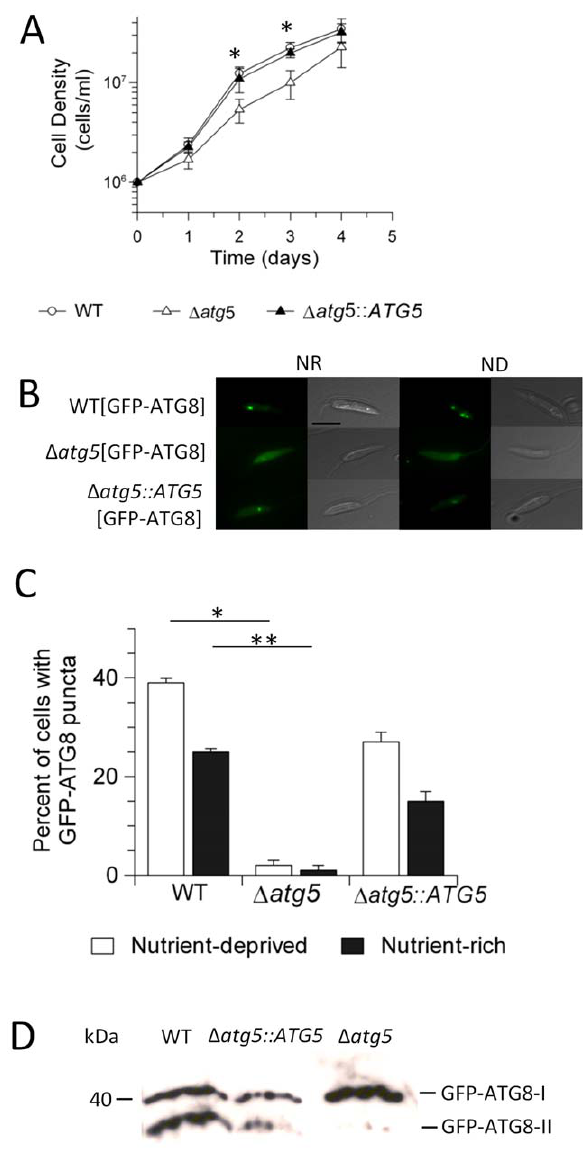
Figure 4. Phenotypic characterisation of D atg5 . (A) Growth curve of Leishmania promastigotes in HOMEM medium at 26 u C. *, D atg5 differed significantly from WT (p , 0.05). (B) The occurrence of GFP-ATG8 puncta in promastigotes after incubation in nutrient-deprived (PBS, ND) and nutrient-rich (HOMEM medium, NR) conditions for 2 h at 26 u C. Scale bar, 10 m m. (C) Occurrence of GFP-ATG8 puncta in promastigotes when incubated in the conditions detailed in (B). Means 6 SD from four independent experiments. * and **, occurrence of GFP-ATG8 puncta in D atg5 were significantly different from in WT in nutrient-deprived and nutrient-rich conditions (p , 0.05). (D) Western blot analysis of extracts of promastigotes expressing GFP-ATG8 at logarithmic growth under standard conditions and probed with a -GFP antibody. The faster migrating, lipidated band is labelled GFP-ATG8-II while the un-lipidated band migrating more slowly is labelled